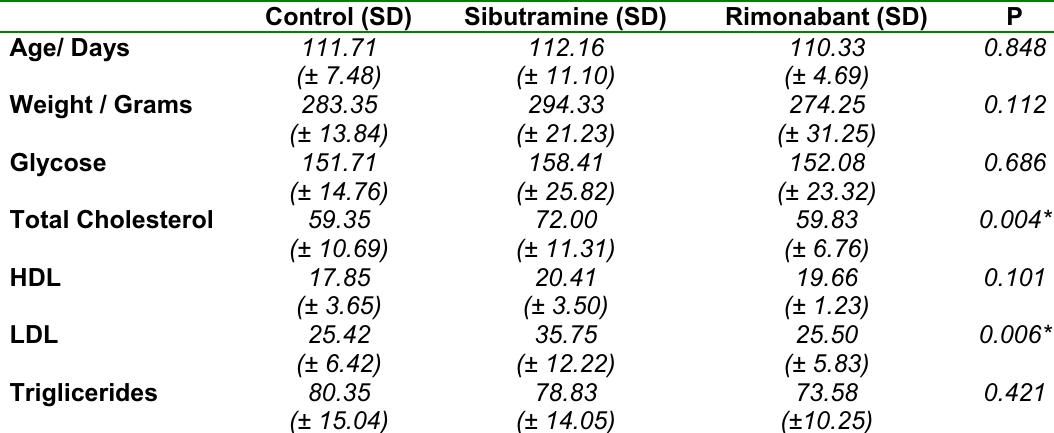
TABLE 1 - Comparison between the groups on set the treatment and after 60 days of hyper caloric